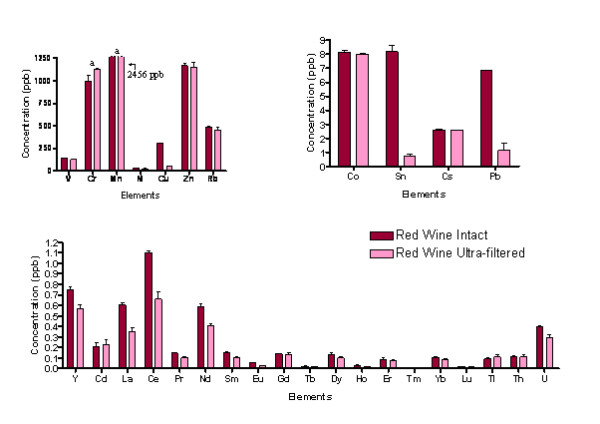
ICP-MS results for intact and ultra-filtered red wine in the concentration ranges of high (up to 1250 ppb); medium (up to 9 ppb); low (up to 1.5 ppb). a = above working range.